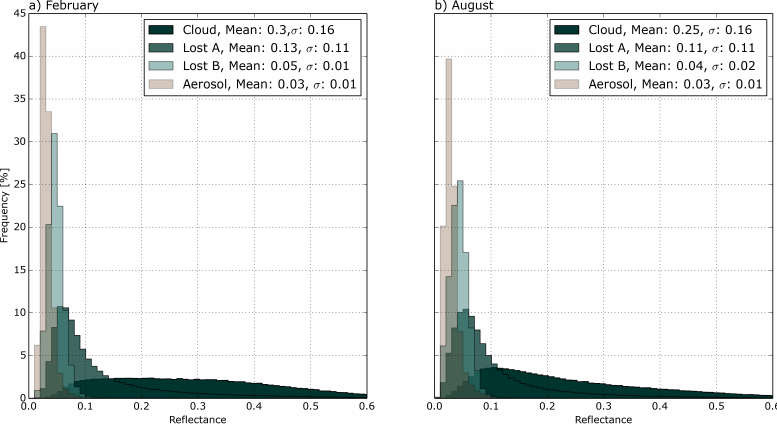
Figure 3. Frequency distribution of the reflectance of the classes: Cloud, Lost A, Lost B and Aerosol.